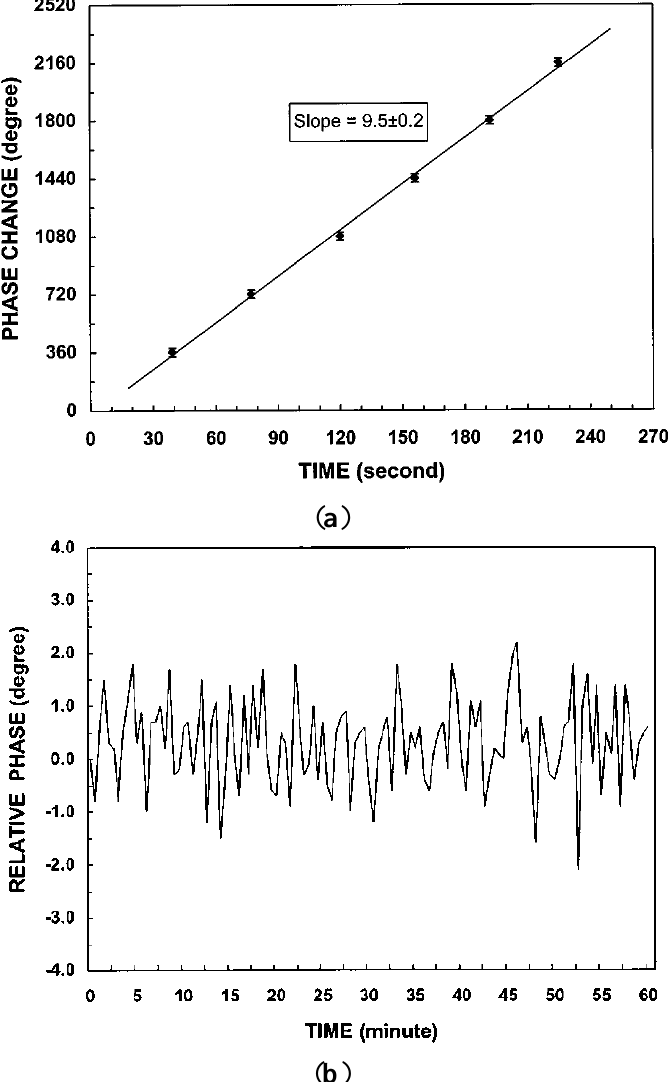
Figure 7. ( a ) A plot of heterodyne signal-phase versus time in a crystal growth experiment [20]; ( b ) Stability measurement of heterodyne detection in the Michelson interferometer setup